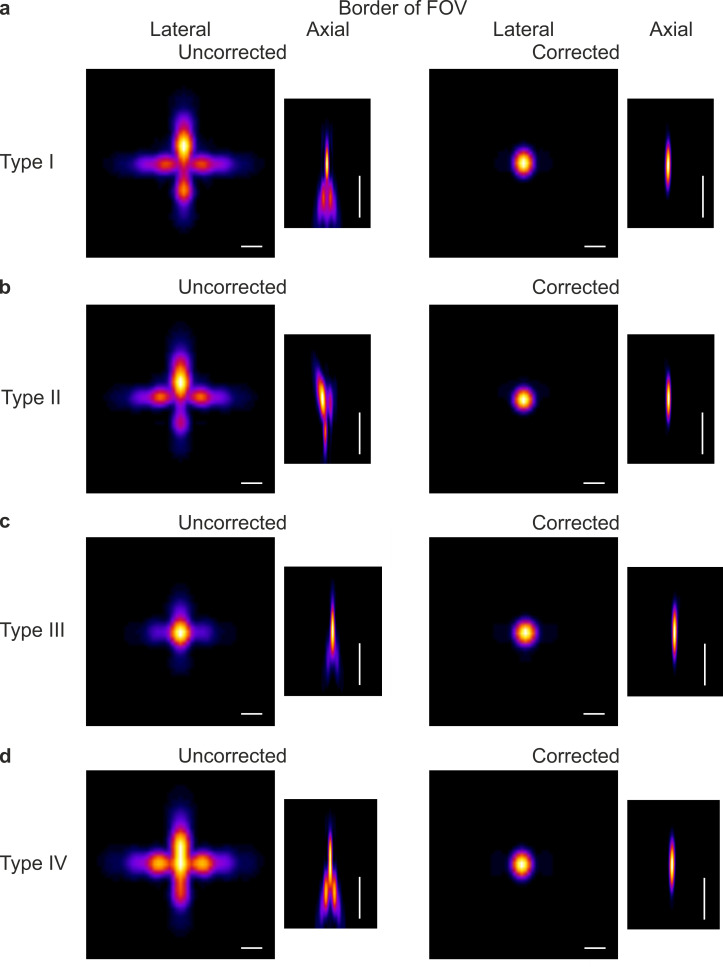
Aberration correction improves the simulated PSF in the peripheral portions of the FOV in eFOV-microendoscopes.(a) Lateral and axial projection of a simulated PSF positioned at the border of the FOV with the uncorrected (left) and corrected (right) type I microendoscopes. Scale bars: 1 μm (lateral), 10 μm (axial). (b) Same as in (a) for type II microendoscopes. (c) Same as in (a) for type III microendoscopes. (d) Same as in (a) for type IV microendoscopes.